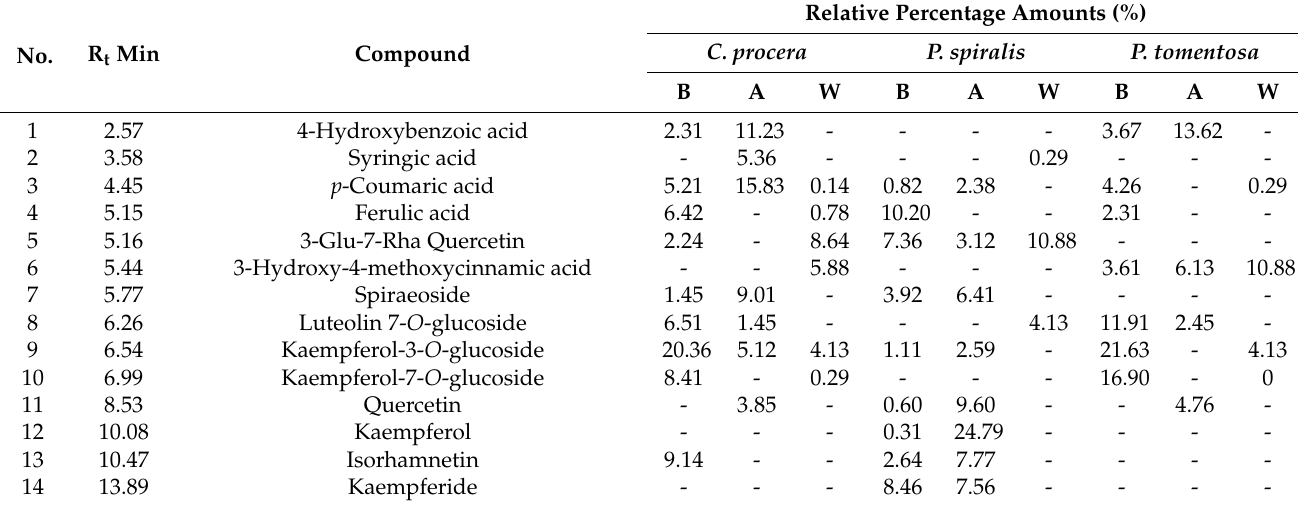
Table 2. LC-QTOF-MS/MS analysis data of detected metabolites from the crude extracts of C. procera , P. spiralis , and P. tomentosa